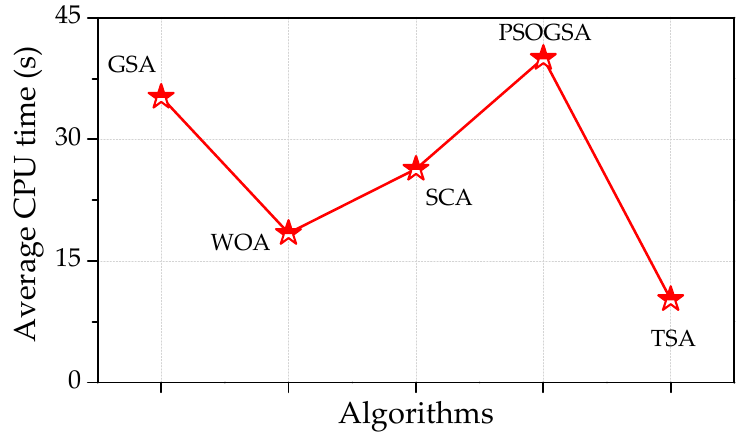
Figure 6. Comparison of the execution time of different metaheuristic algorithms.